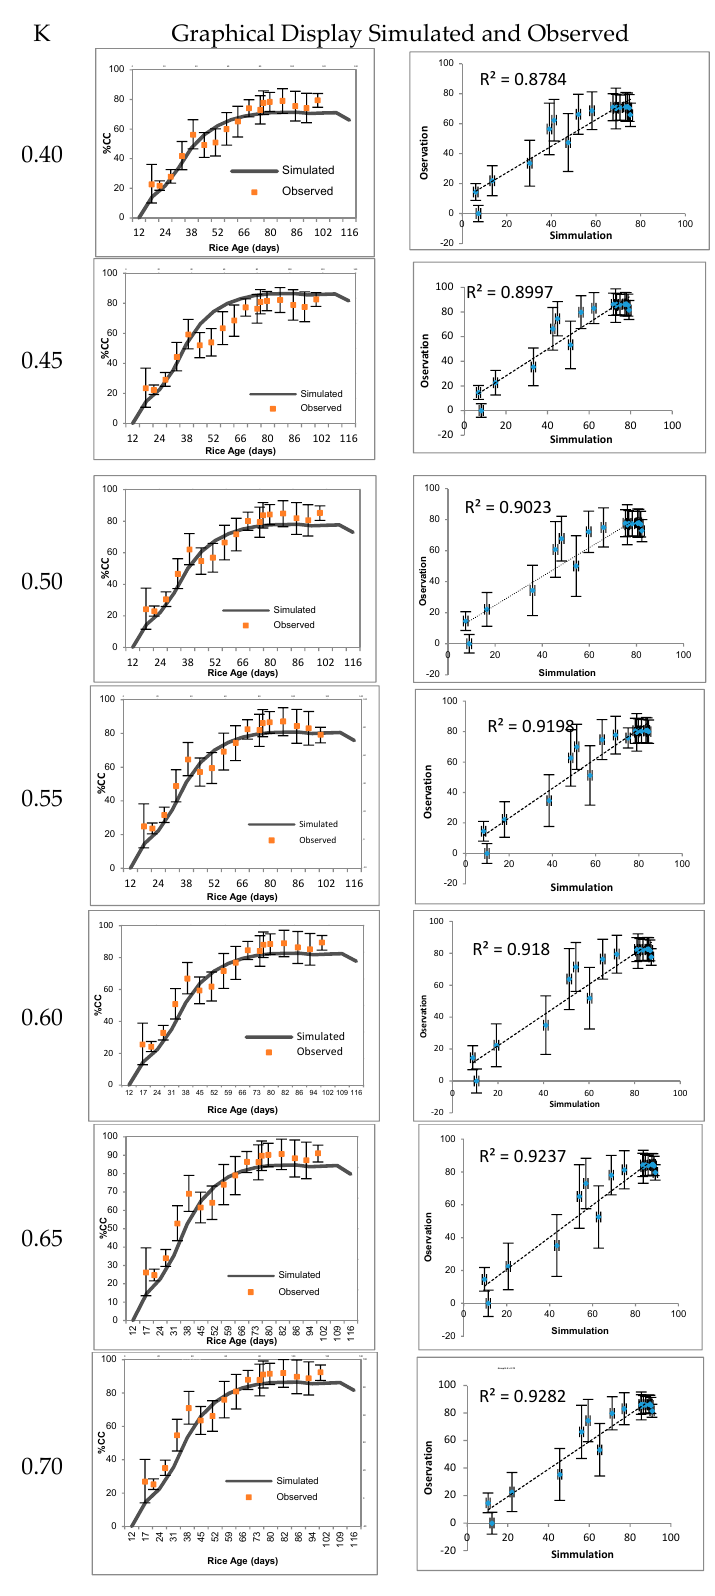
Figure 6. Graph and statistic display of the green canopy cover (CC) of manual transplanted rice (B); error bar represents the standard deviation of the observed CC. Table 6. Statistical indicators used for evaluating the CC simulation performance of the model using different K values for Groups A and B.